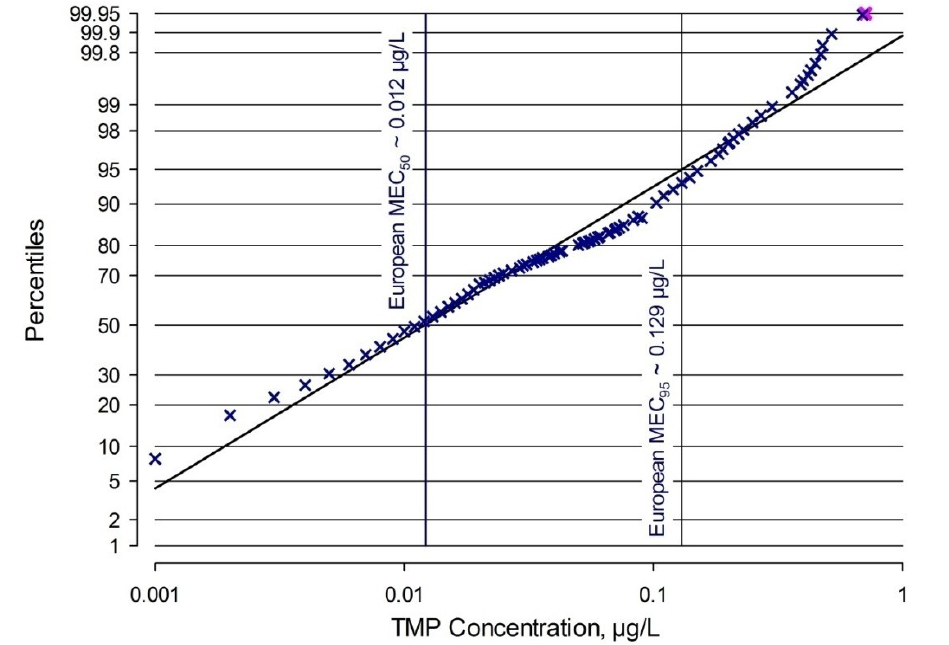
Figure 2. Compiled European surface water measured environmental concentrations (MECs) for